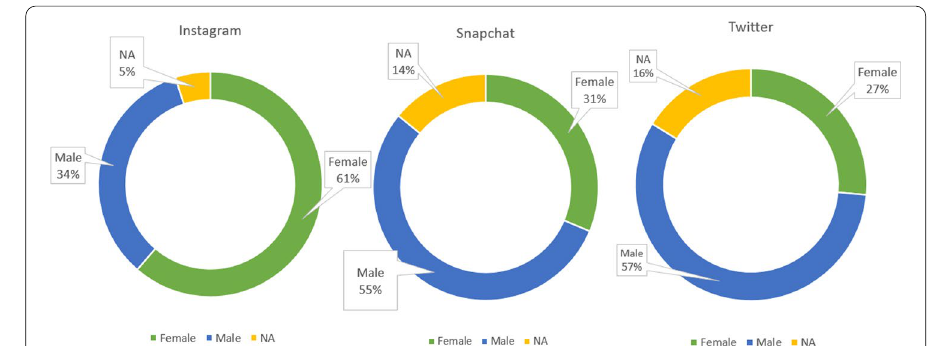
Fig. 25 The percentage of gender in all platforms